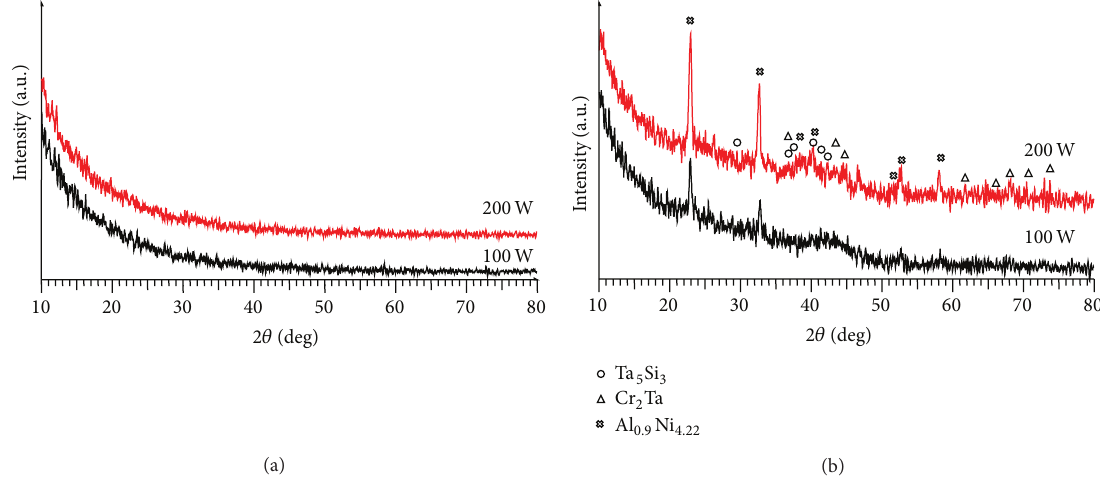
Figure 3: X-ray diffraction patterns of Ni-Cr-Si-Al-Ta thin films with different sputtering powers: (a) as-deposited and annealed at (b) 500 ∘ C.